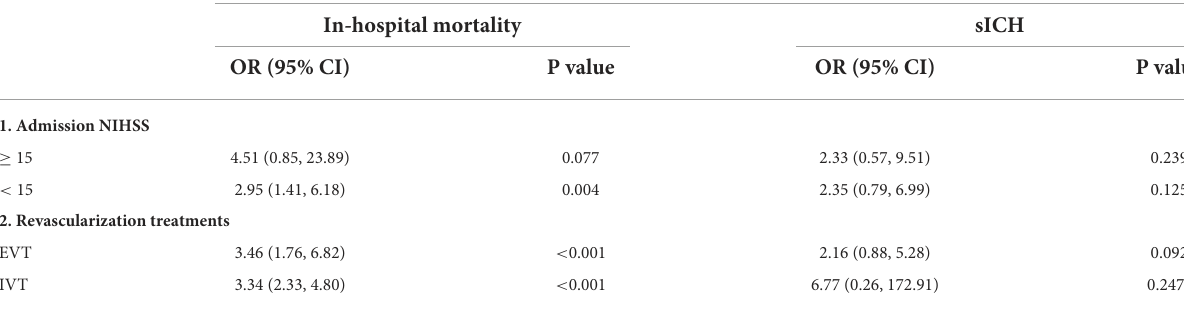
TABLE 3 Subgroup analysis of safety